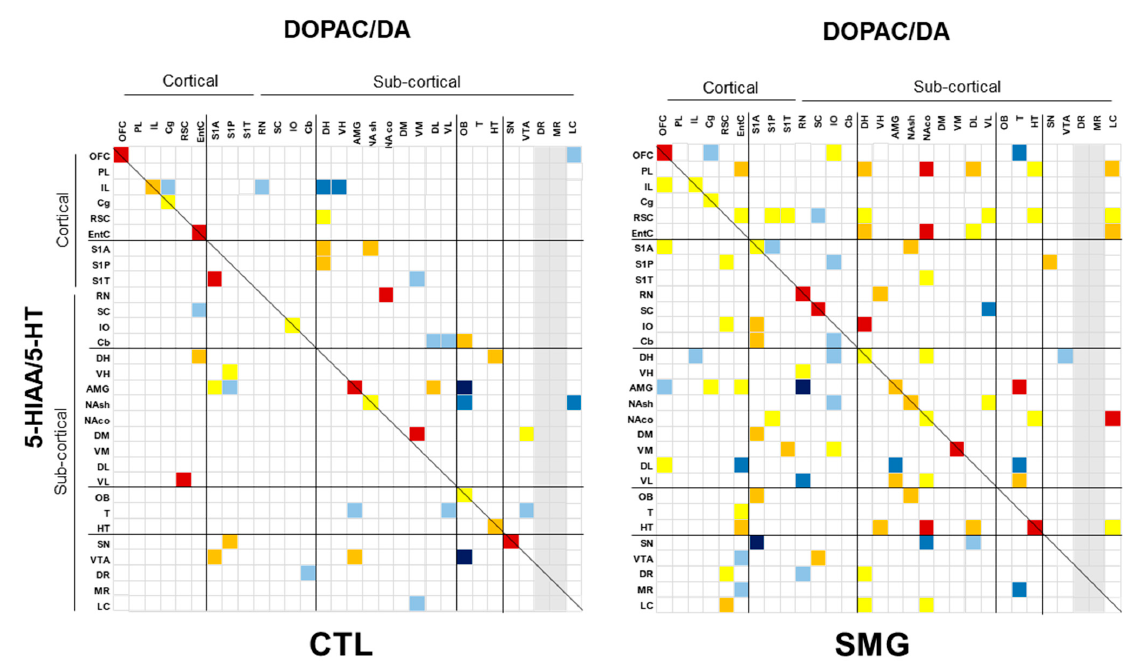
Figure 9. Correlations established between the ratios of DOPAC/DA and 5-HIAA/5-HT across the brain for CTL and SMG rats. Positive correlations are reported in yellow (r > 0.6) to red (r > 0.8). Negative correlations are reported in light blue (r < − 0.6) to deep blue (r < − 0.8). Only significant correlations ( p < 0.05) are reported.